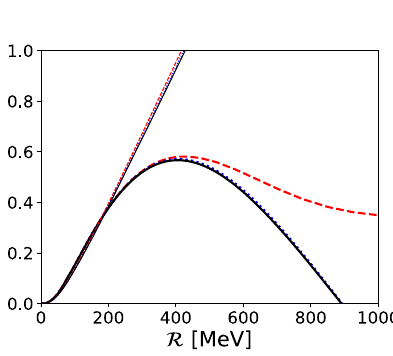
Figure 9. Estimate of ¯ Ψ λ ( R ) for various deuteron wave func- tions: Results for λ = 0 . 8 , 1 . 6 , 4 GeV are shown as red (dashed), blue (dotted) and black (solid) curves, respectively. The thick (thin) lines depict the results with (without) OPE. Fig- ure from [63].